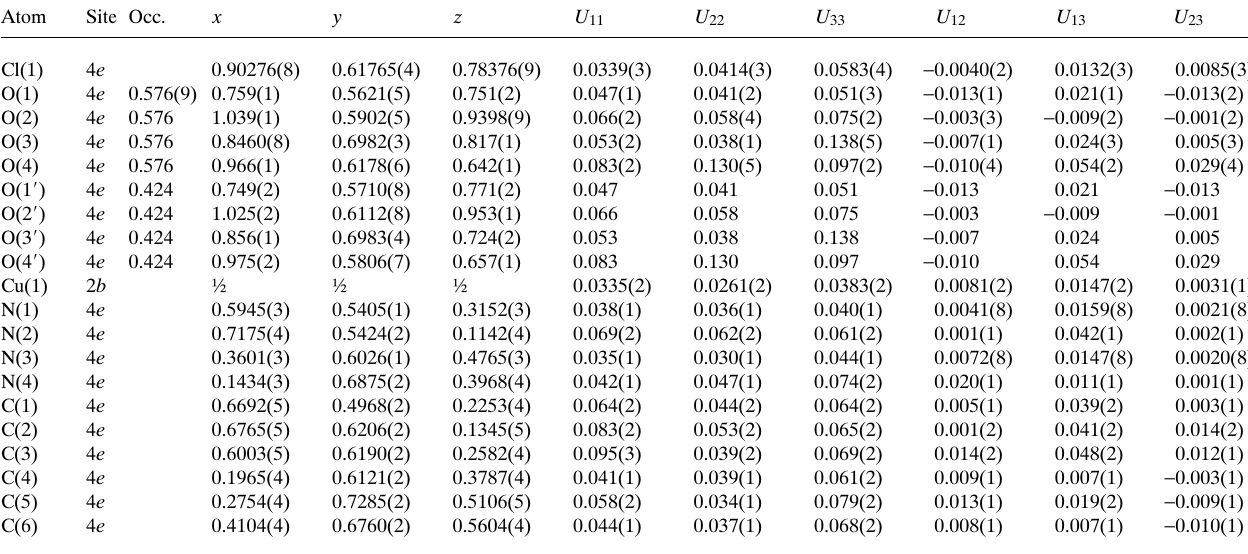
Table 3. Atomic coordinates and displacement parameters (in Å 2 ) . Atom Site